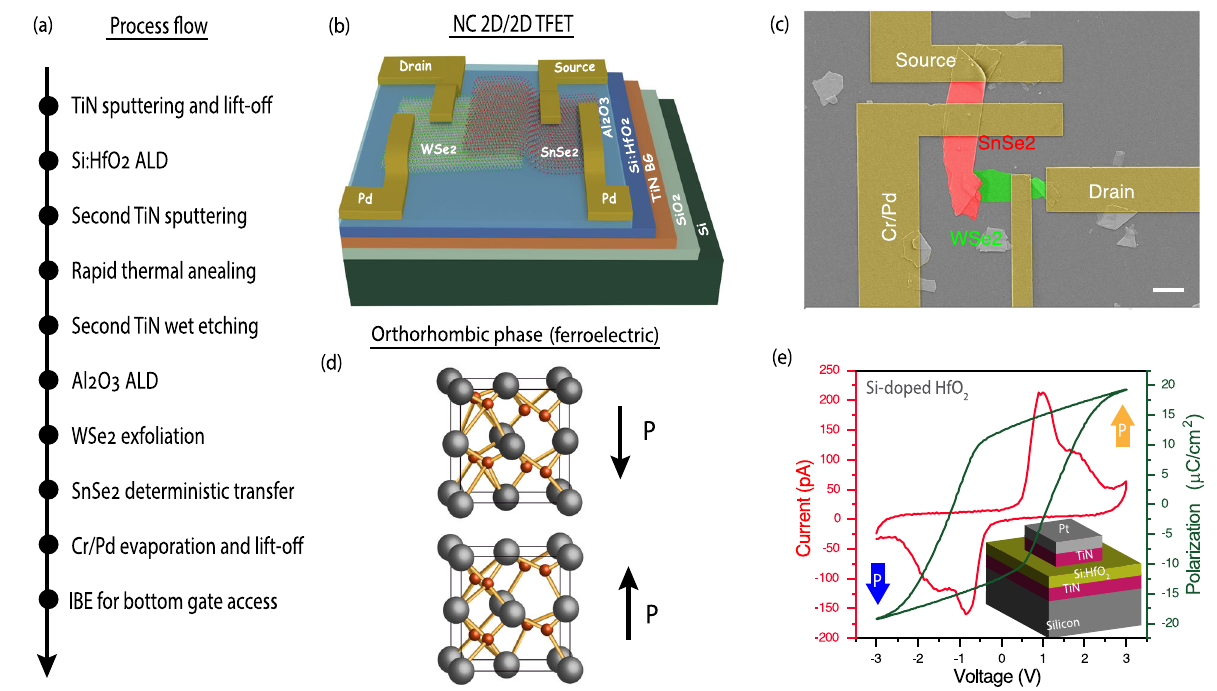
Fig. 2 Fully integrated NC 2D/2D tunnel FET. a Summary of the process fl ow followed for the realization of the NC WSe 2 /SnSe 2 TFET. b Schematic diagram of the NC 2D/2D vdW vertical TFET in which 16 nm of Si:HfO 2 is integrated into the gate stack (4-nm-thick Al 2 O 3 ) of a back gated WSe 2 /SnSe 2 heterojunction TFET. c SEM image of the fabricated device, showing WSe 2 and SnSe 2 fl akes for the junction, the Pd contacts, and the overlapped tunneling region (scale bar 2 µm). d The crystal structure of Si:HfO 2 in its two stable polarization states,